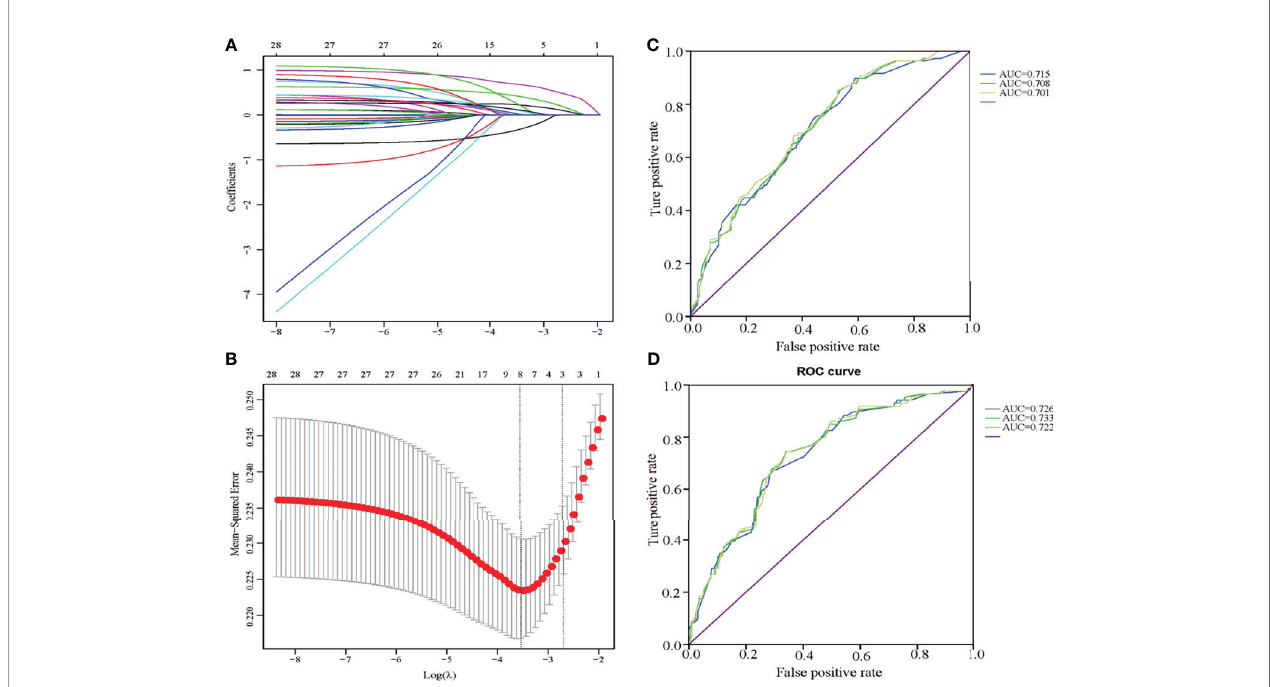
FIGURE 3 | Multivariate risk model constructed by LASSO regression (A, B) and ROC curves of the LLNM risk scores for cN0 PTC patients with one to two CLNMs (C, D) . (A, B) The LASSO model is best constructed with eight factors when Log( l ) equals to -3.5. The eight factors were tumor size 1 (over 10 mm), tumor size 2 (over 20 mm), tumor location, HT, calci fi cation, bilaterality, CLNM number, and nodular goiter. (C) The ROC curve of patients who underwent LLND (levels II, III, and IV) presented AUCs of 0.715 (preoperative assessment group with six factors, blue line), 0.708 (intraoperative frozen group with CLNM number enrolled, green line), and 0.701 (postoperative assessment group, yellow line). (D) The ROC curve of patients who underwent LLND (levels III and IV) presented AUCs of 0.726 (preoperative assessment group with six factors, blue line), 0.733 (intraoperative frozen group, green line), and 0.722 (postoperative assessment group, yellow